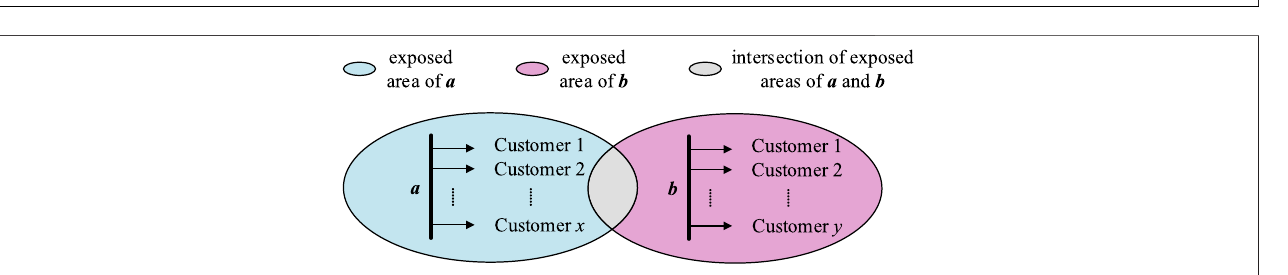
FIGURE A1 | Calculation of Economic Loss of Voltage Sag.